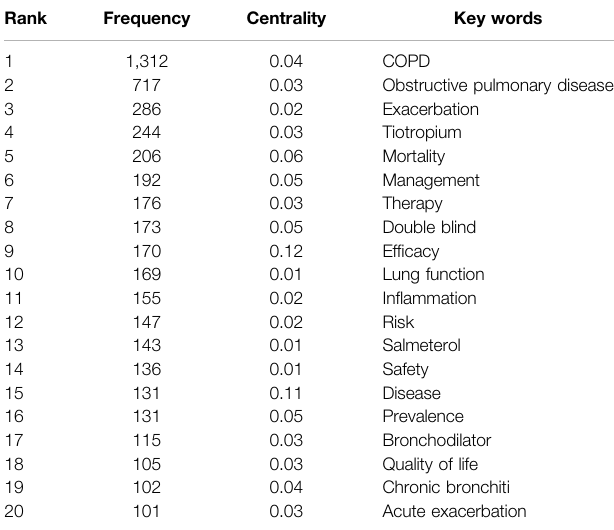
TABLE 6 | The top 20 keywords of COPD drugs-related studies that were published from 1980 to 2021. Rank Frequency Centrality